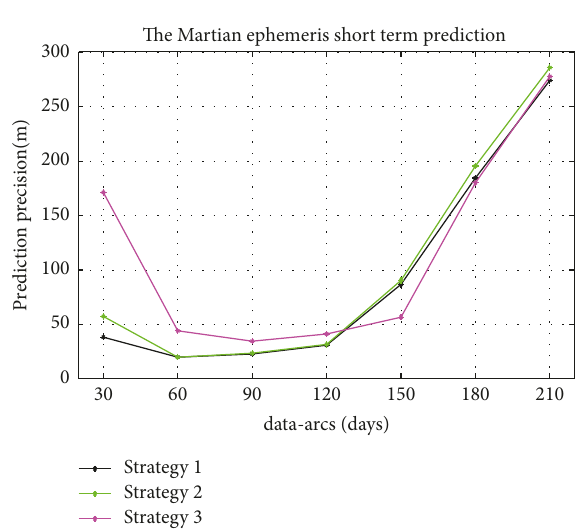
Figure 4: The Martian ephemeris short-term prediction under dif- ferent observing strategies.